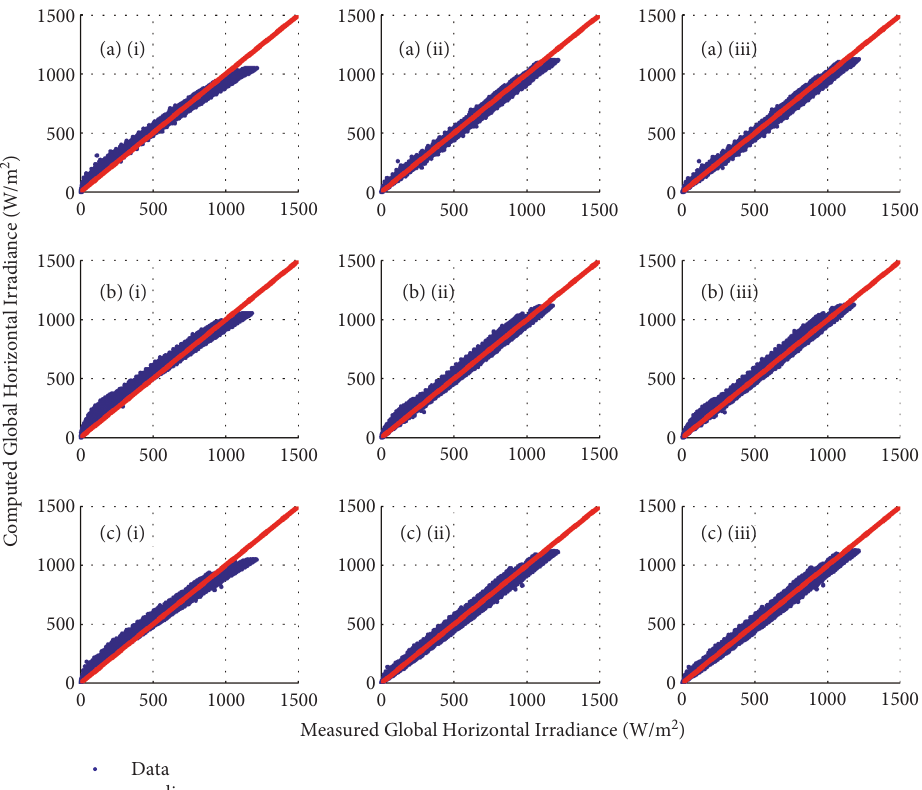
Figure 5: Modelled vs. measured GHI at (a) Kokerboom, (b) Arandis, and (c) Auas; for (i) B–D model, (ii) R–S model, and (iii) A–B–C–G